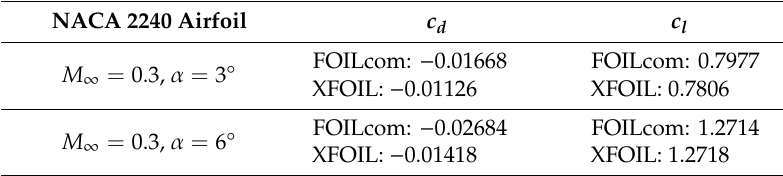
Figure 26. The airfoil surface pressure coe ffi cient distribution for NACA 2240 airfoil ( M ∞ = 0.3, α = 6 ◦ ) using XFOIL. Table 2. Drag and lift coefficients using FOILcom and XFOIL.